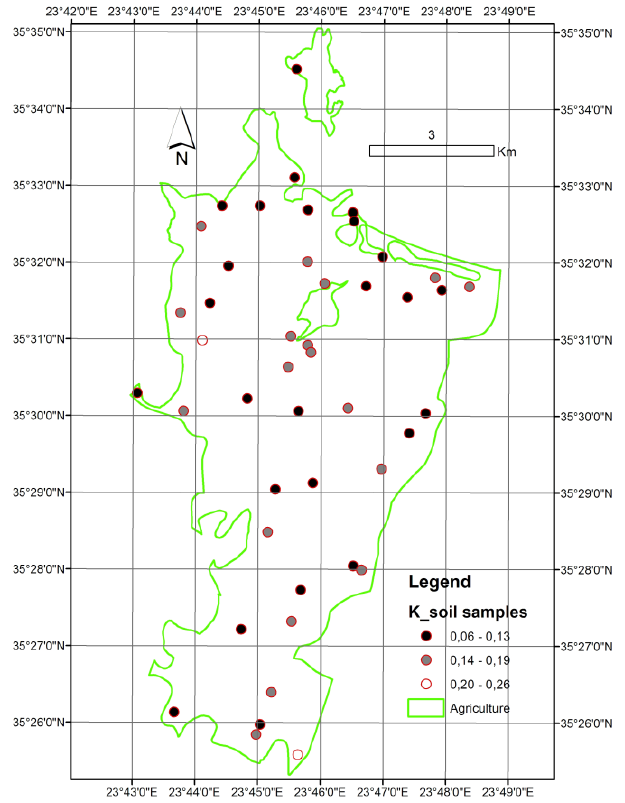
Figure 4. The sampled locations and the calculated soil erodibility (K) values.